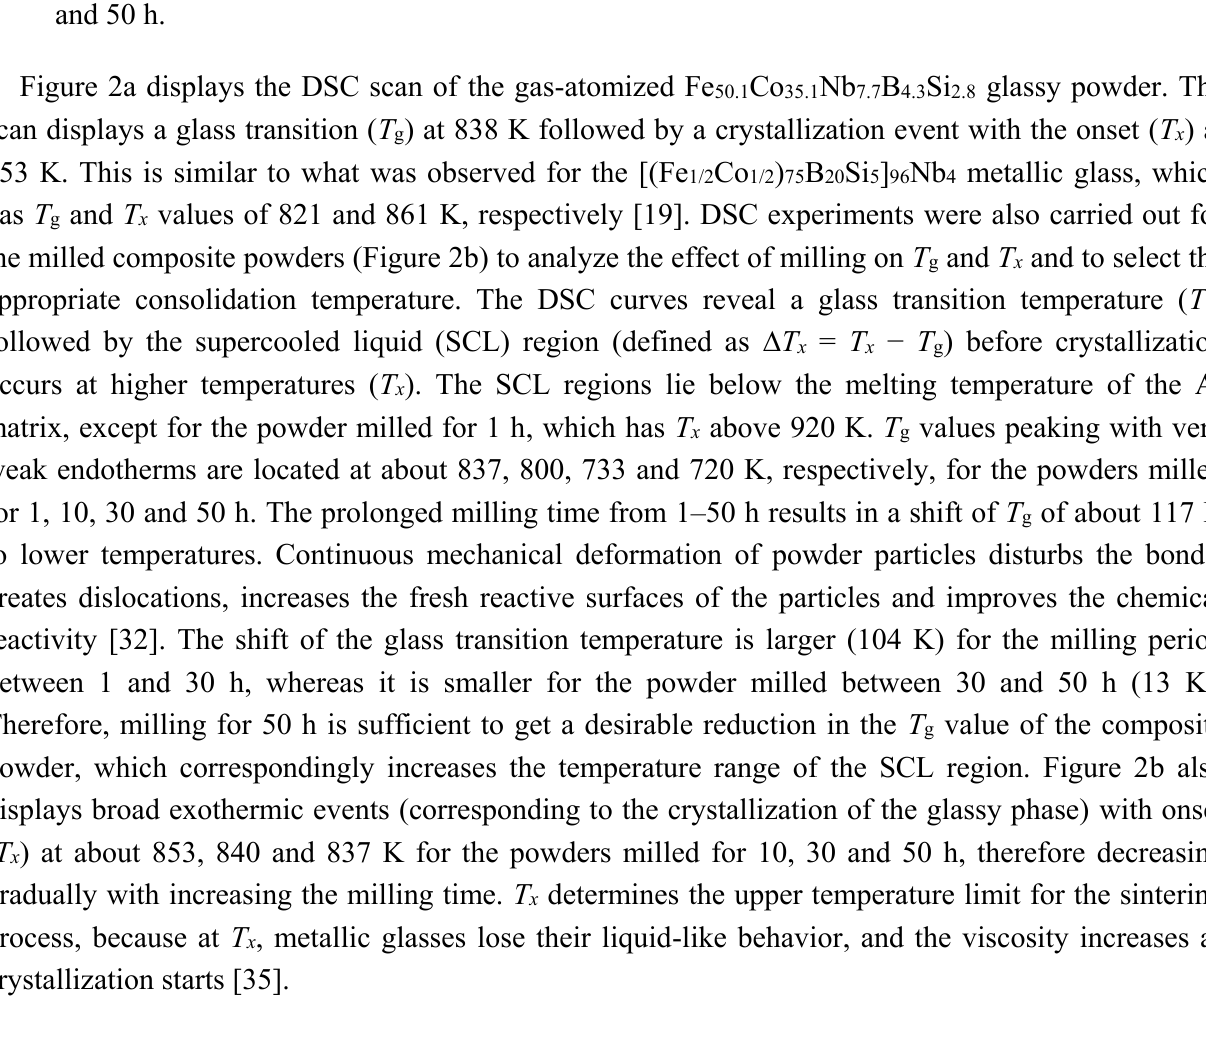
Figure 1. XRD patterns of the starting and composite powders milled for different times: ( a ) pure Al and metallic glass powders; and ( b ) composite powders milled for 1, 10, 30 and 50